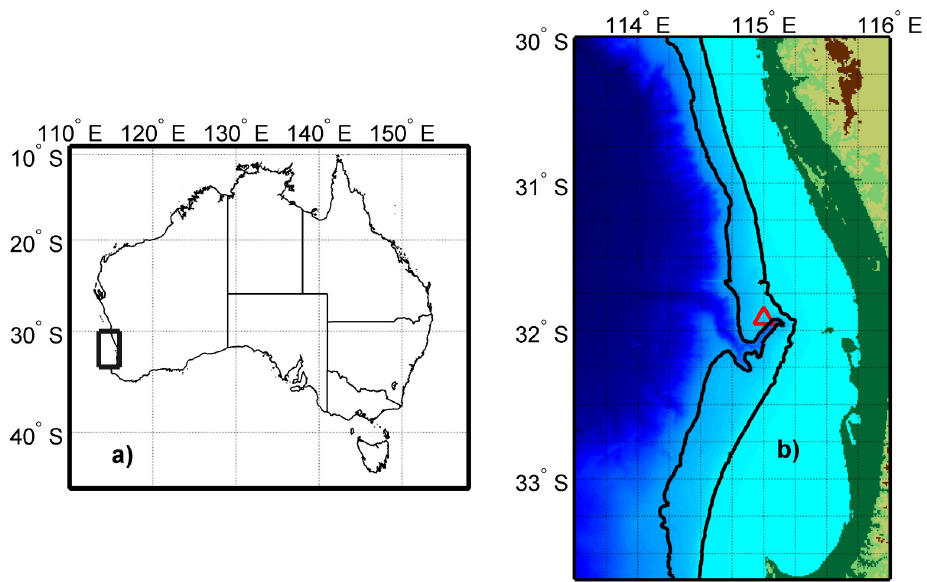
Fig 1. Location of Perth Canyon sampling area. The area sampled within Australia is shown by the rectangle in a), the Perth Canyon is shown on b), centred at 32˚ S 115˚ E, the general area of sea noise moorings is shown by the red triangle and the 1000 and 200 m depth contours are shown by the black curves (west and east curves respectively). Bathymetry from [38].